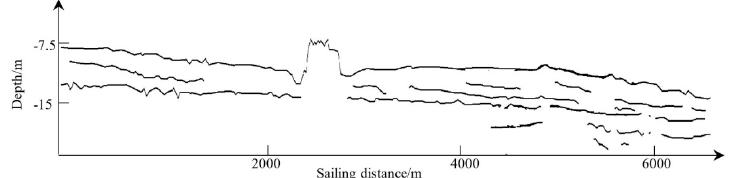
Figure 10. Manual horizon picking result. Table 1. Analysis of the picked horizons.